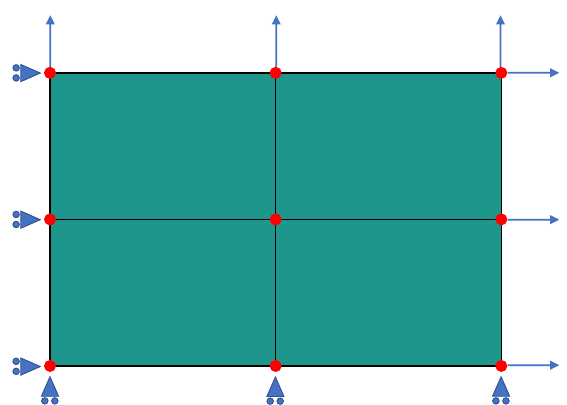
Figure 5. The finite element model on which four different load cases are studied consists of four quadrilateral elements (green) with linear shape function, and at total of nine nodes (red) situated at the corners of the elements. The bottom and left-hand-side boundary nodes are restricted to zero normal displacement (blue triangles), and the loading is applied on top and right-hand-side-nodes (blue arrows), as described in the text.